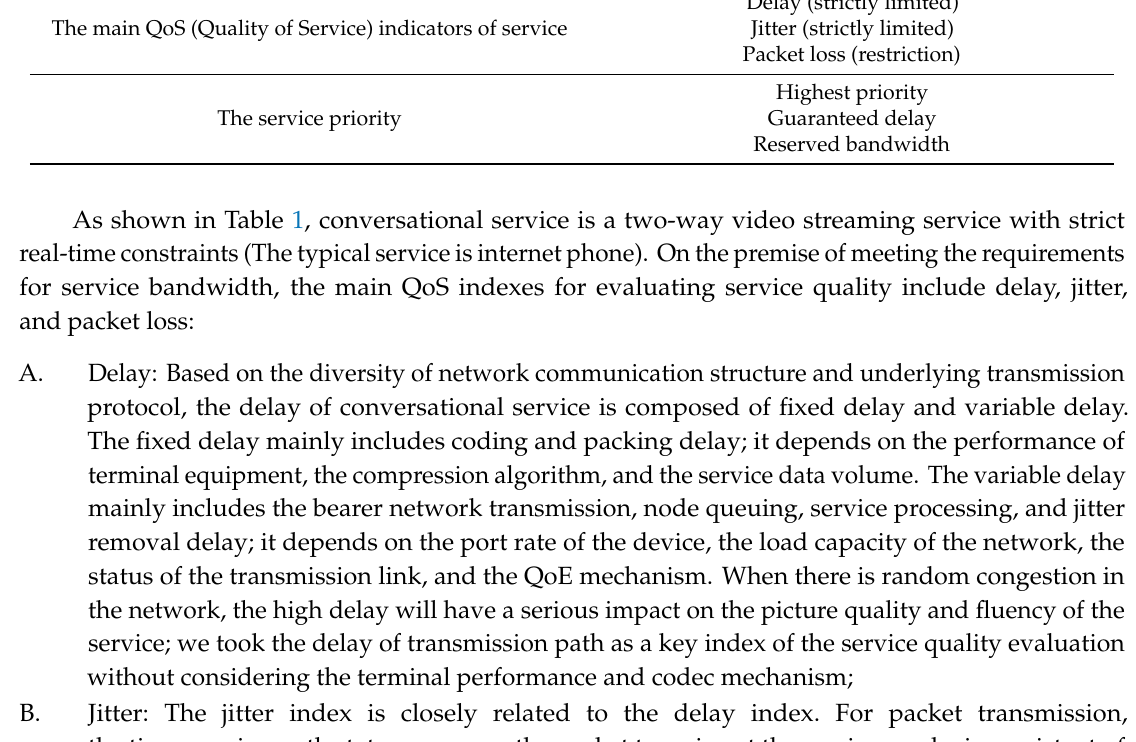
Table 1. The QoE (Quality of Experience) characteristics of conversational service.